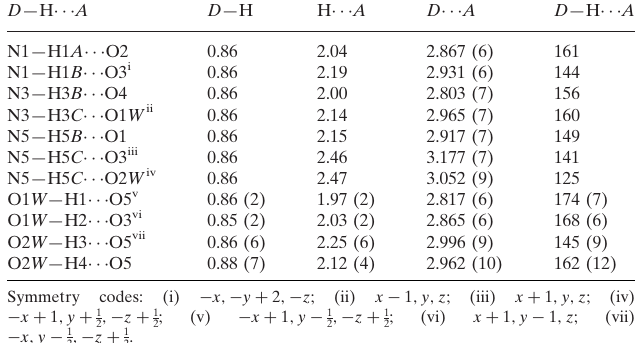
Hydrogen-bond geometry (A˚ , (cid:3) ). D —H (cid:2)(cid:2)(cid:2)